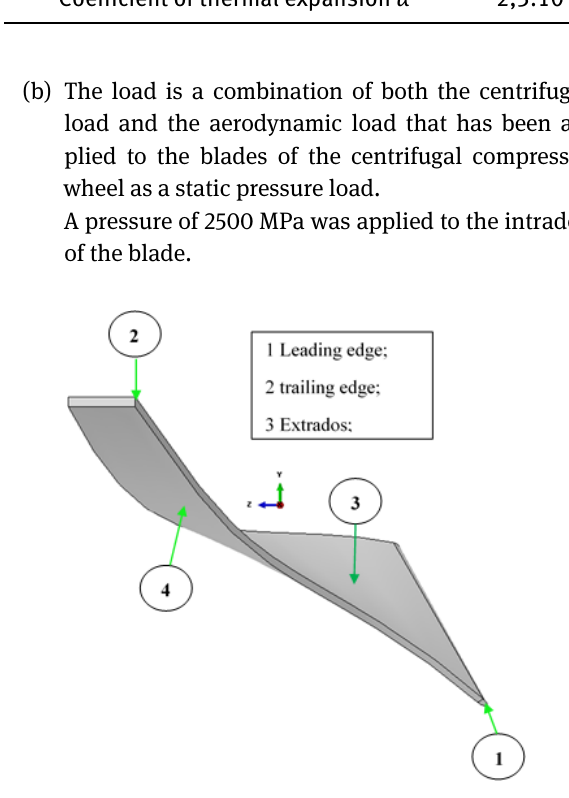
Figure 5: Geometry of the blade of the centrifugal compressor under